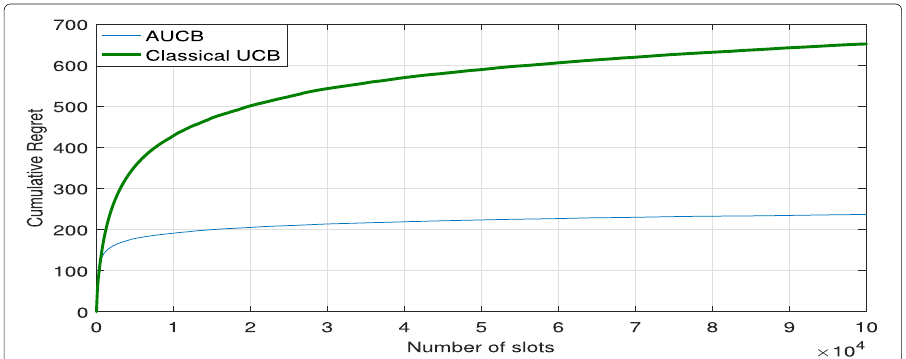
Fig. 7 Regret comparison for two approaches under the side channel